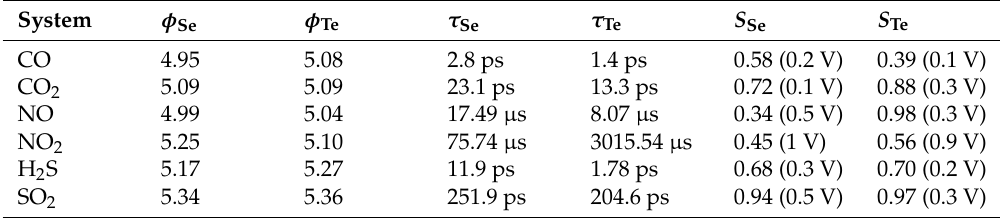
Table 2. Calculated work function ( φ ) when gas molecules absorbed on the surface of the Janus NbSeTe monolayer, recovery time ( τ ) at room temperature, and sensitivity ( S ) at a particular